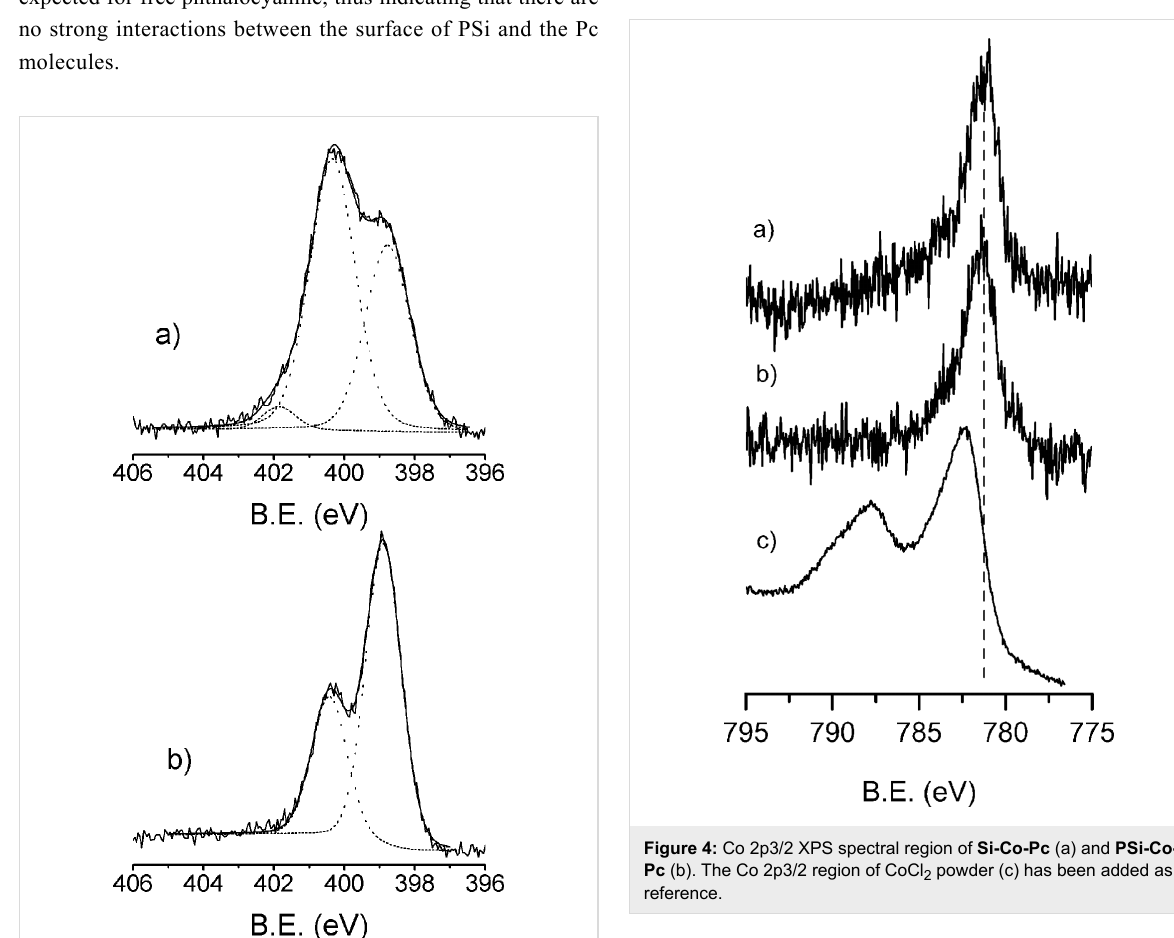
Metalation of SAM